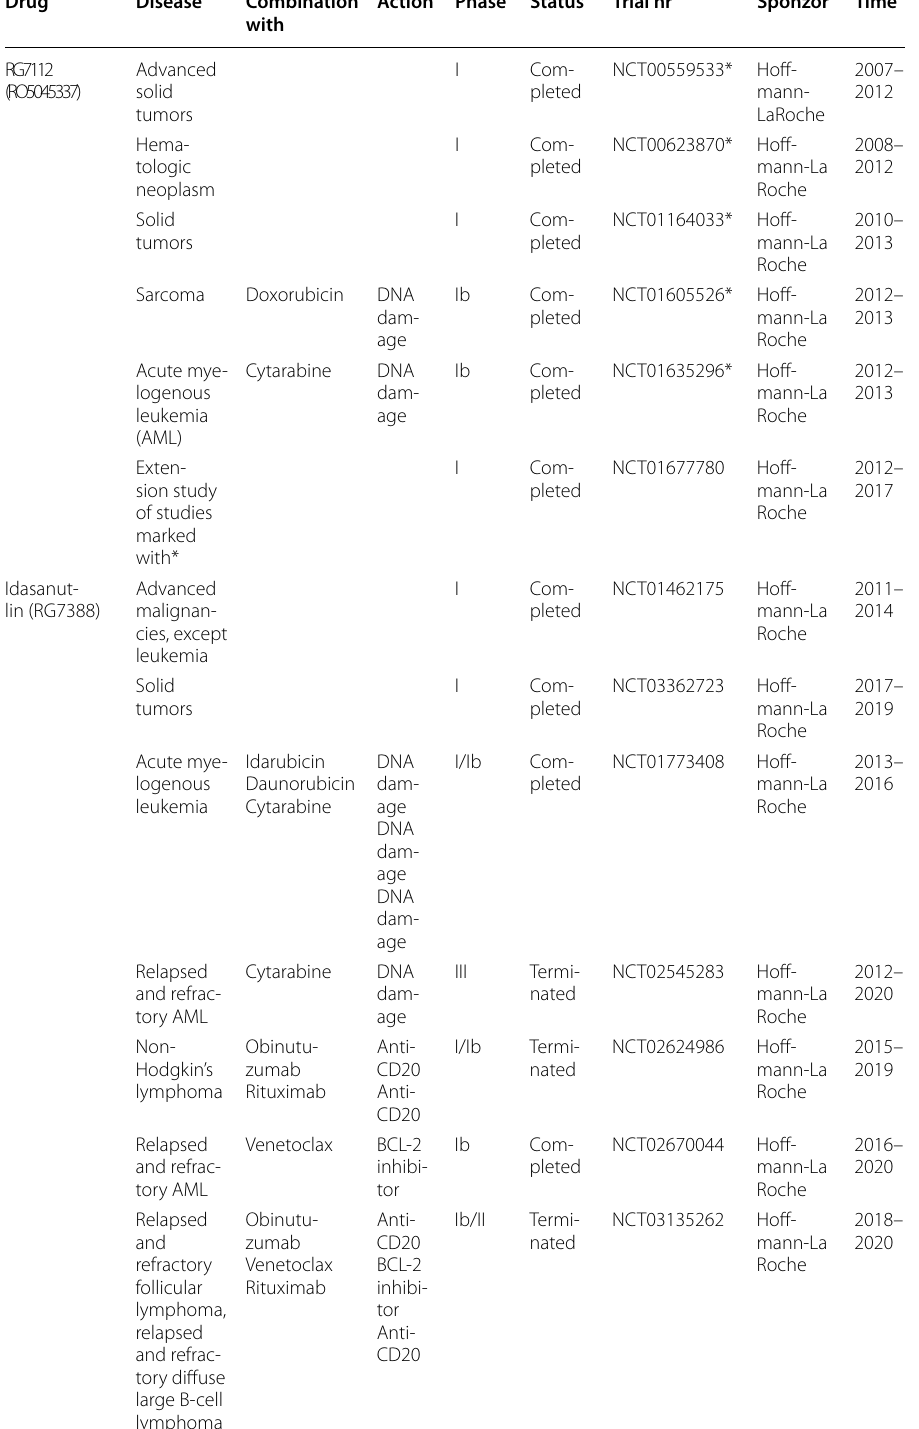
Table 1 List of MDM2‑p53 inhibitors in completed clinical trials Drug Disease Combination Action Phase Status with RG7112